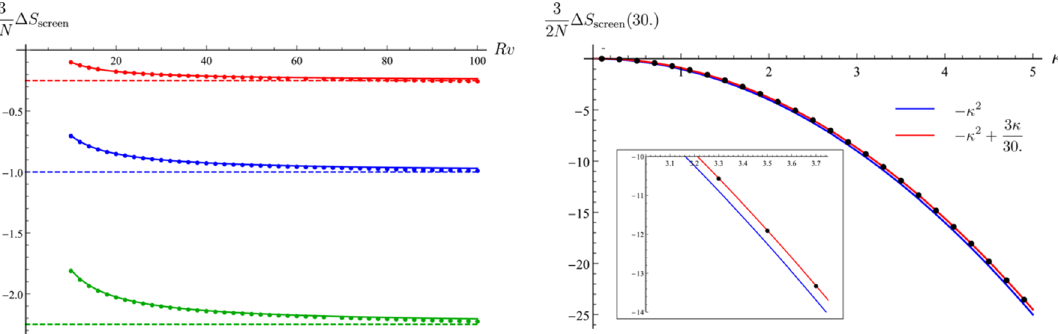
Figure 4 . Left: the dots are our numerical results for ∆ S screen defined in eq. (4.43), divided by 2 N/ 3 , as a function of the region’s size Rv for κ = 0 . 5 (red), 1 (blue), and 1 . 5 (green). The solid (cid:0) (cid:1) lines are the expression in eq. (4.42) without the O ( Rv ) − 2 corrections, and the horizontal dashed lines are − κ 2 . Right: the dots are our numerical results for ∆ S screen / (2 N/ 3) for Rv = 30 , for various κ . The solid blue line is − κ 2 while the solid red line is − κ 2 + 3 κ/ ( Rv ) . The inset is a close-up that clearly shows the latter is a better approximation to our numerical results than the